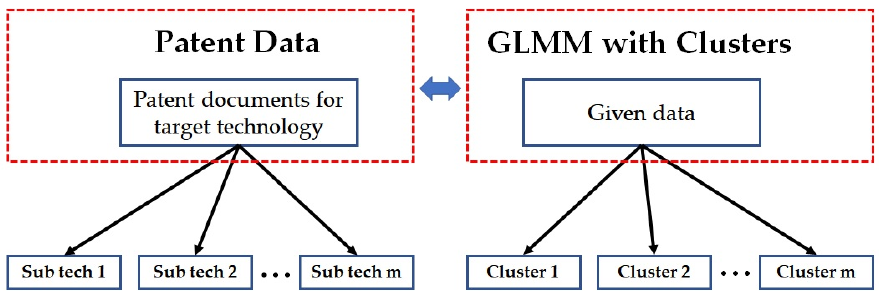
Figure 3. Patent data and GLMM with clusters.